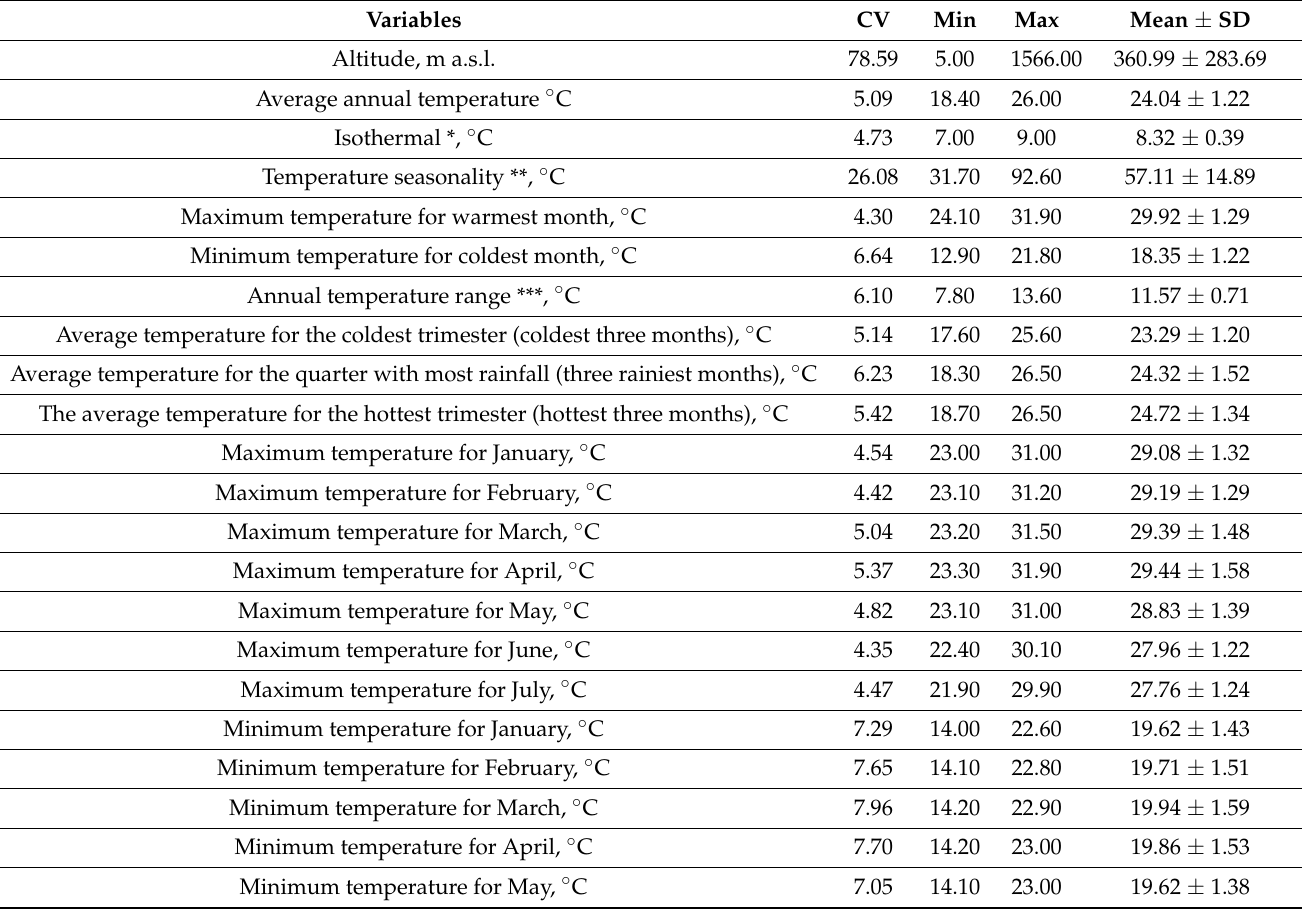
Table 3. Ecogeographic variability of quantitative traits in the Ecuador cassava